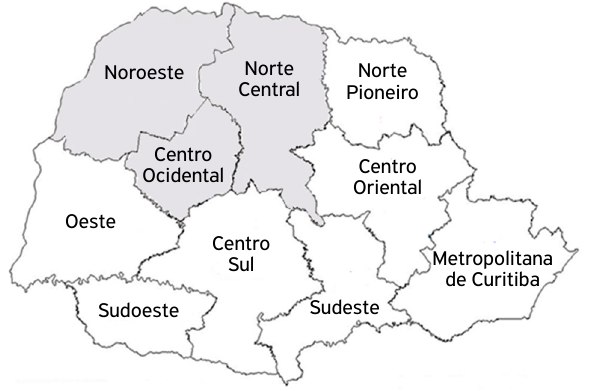
Figura 1. Mesorregiões geográficas do estado do Paraná, com destaque para as áreas de abrangência do